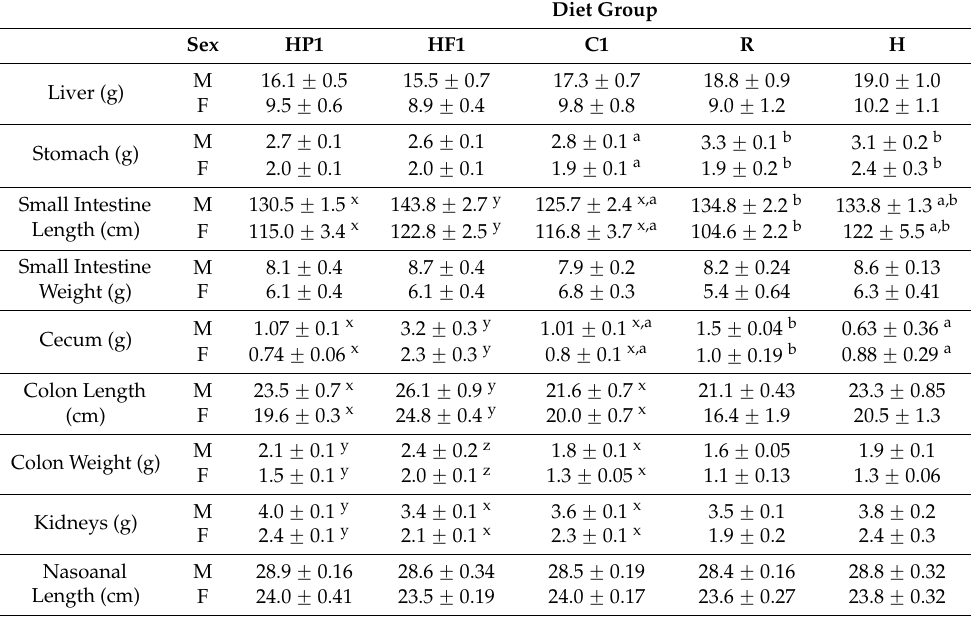
Table 2. Physical characteristics of offspring at 28 weeks.